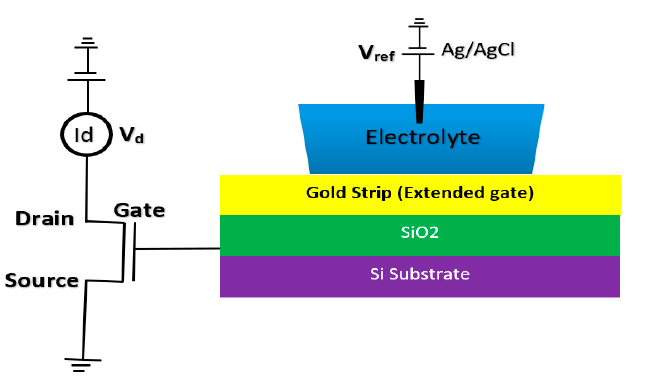
Figure 10. Extended gate Chem/BioFET structure in which the gold gate was deposited on SiO 2 and Si substrate. The extended gate was connected to the fluidic channel through a liquid cell on top of the sensor.